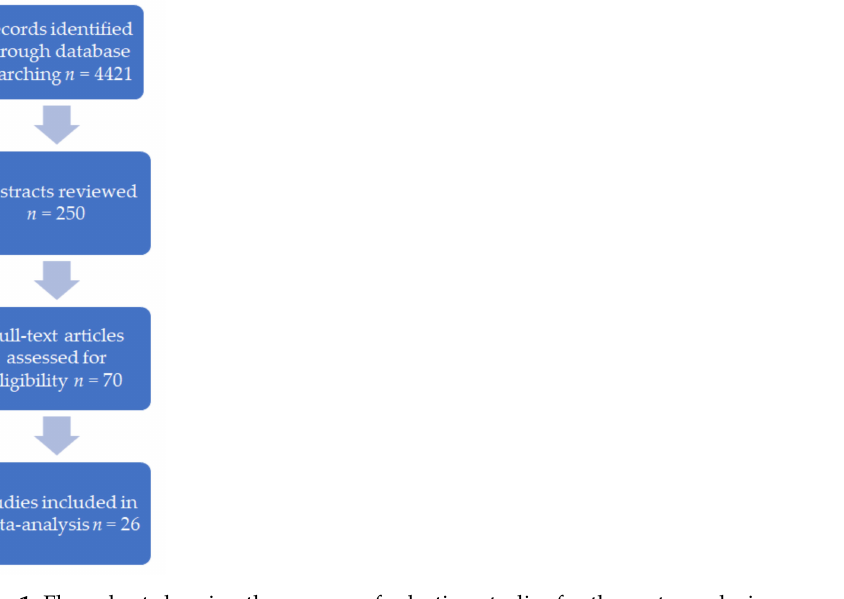
Figure 1. Flow chart showing the process of selecting studies for the meta-analysis.